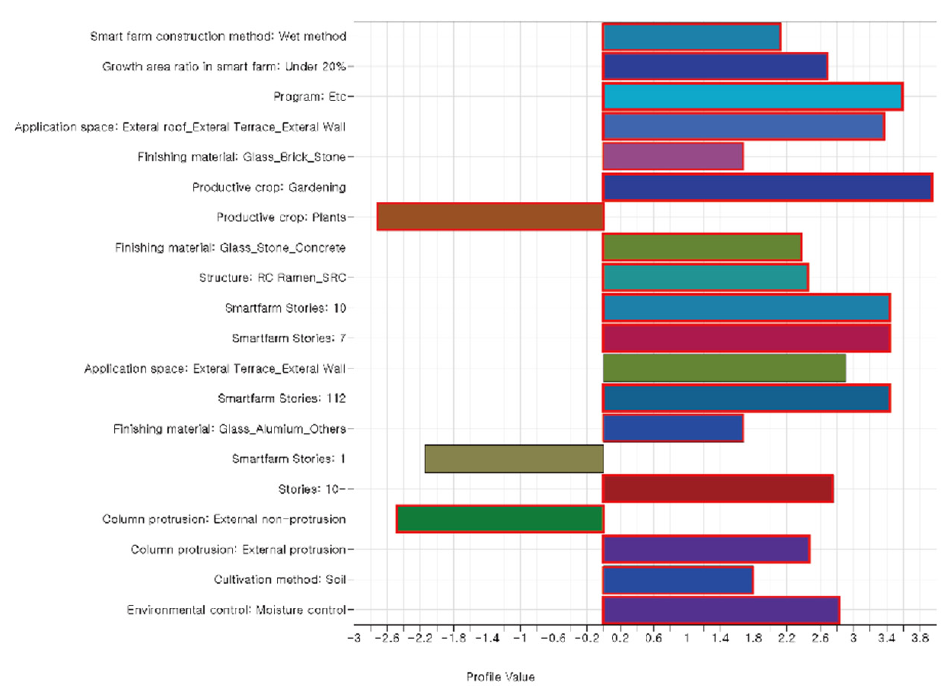
Figure A7. C7. Figure A7.